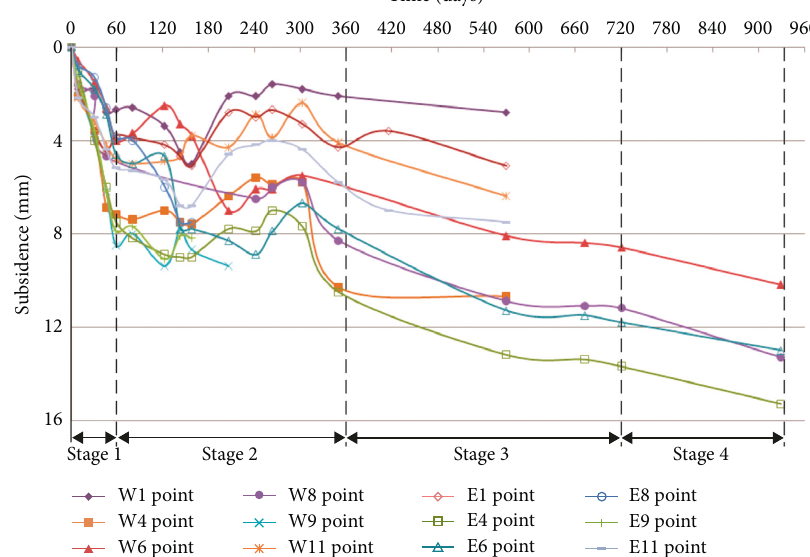
Figure 12: Subsidence values of the monitoring points.